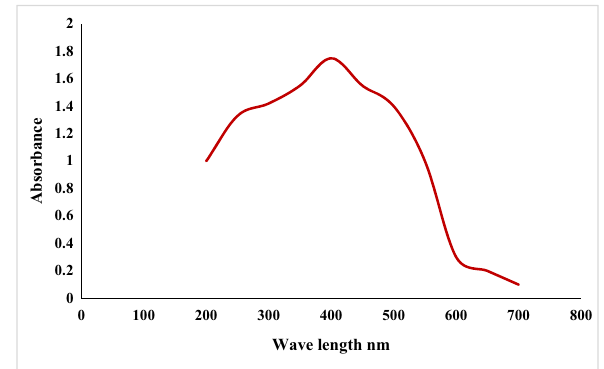
Table 2: Primer sequence used for relative mRNA expression levels